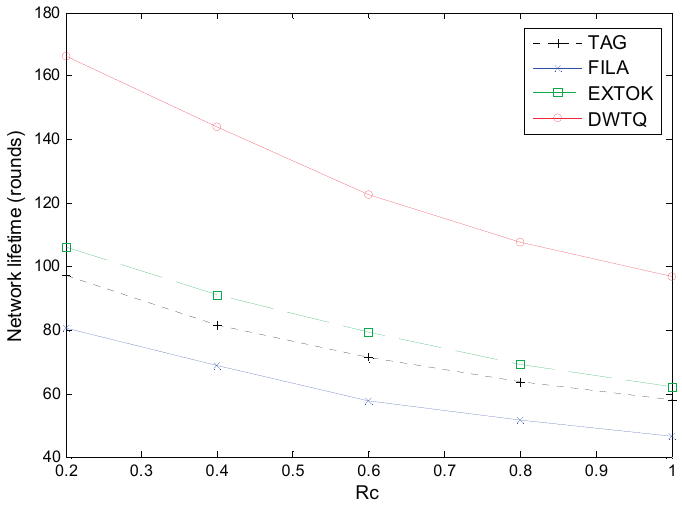
Figure 18. Network lifetime with different (cid:1844)